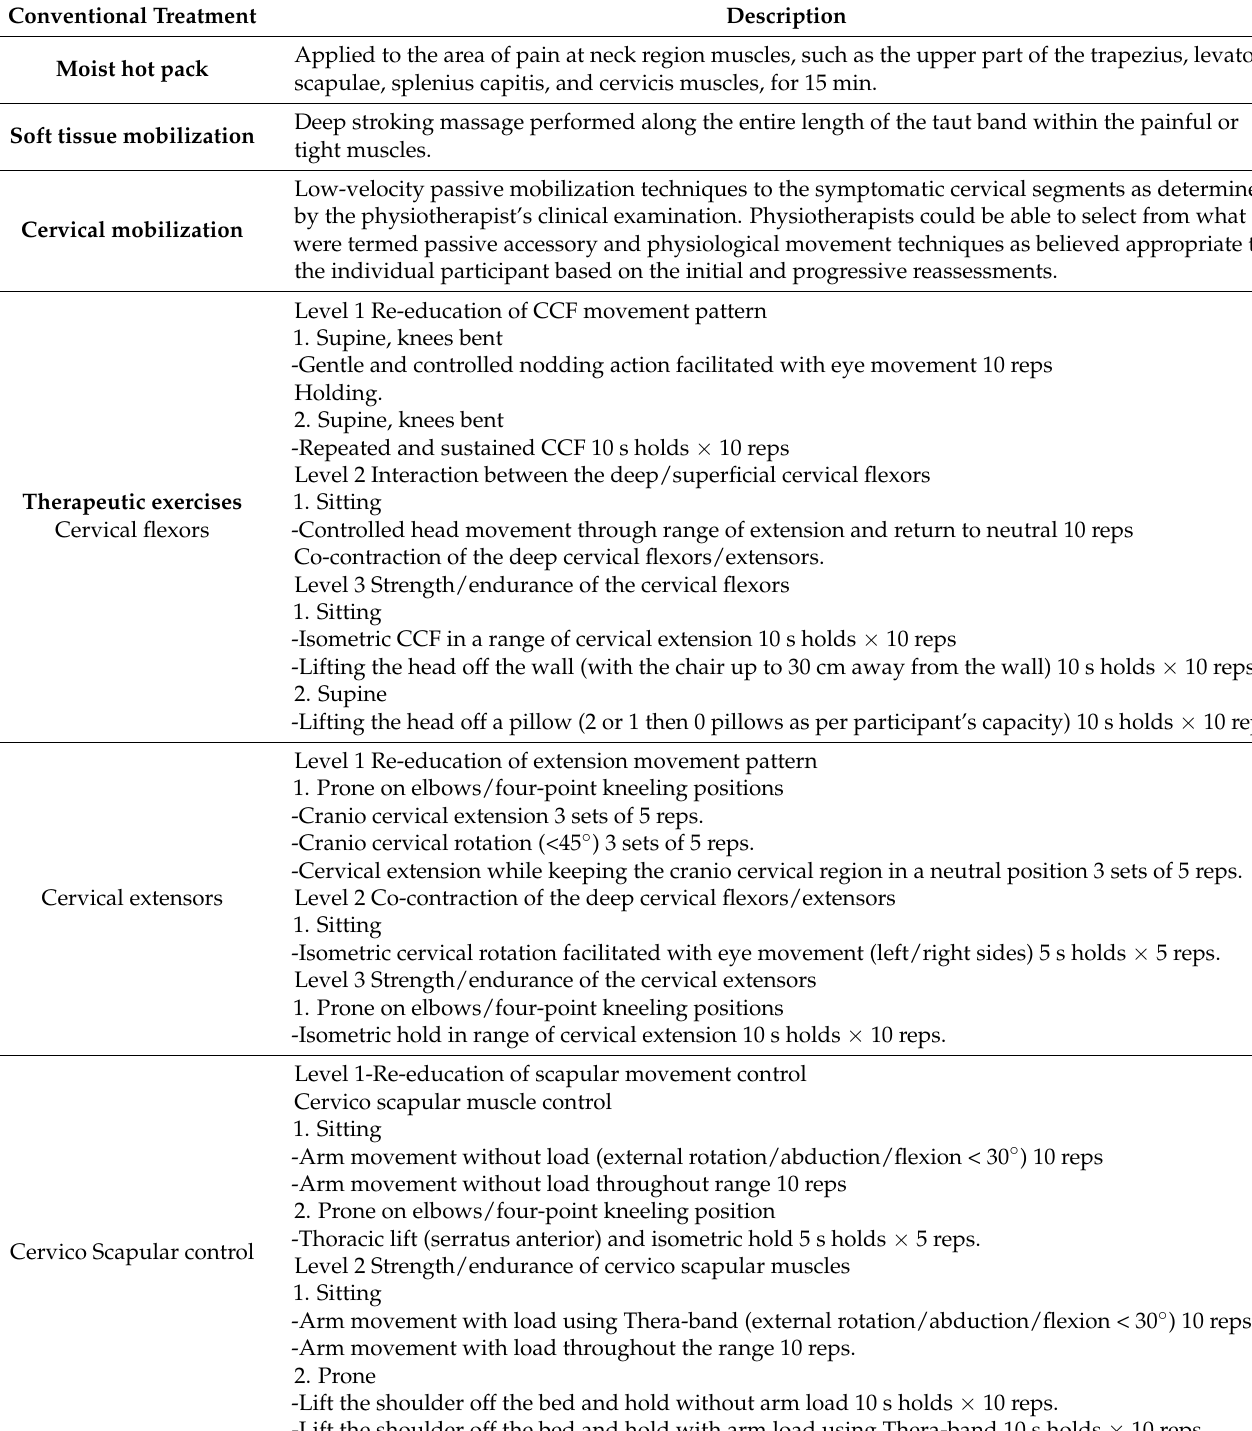
Table 1. Both the study and control groups received conventional or local treatment consisting of a moist hot pack, soft tissue mobilization, manual therapy, and therapeutic exercises. Description of this conventional treatment, exercise prescription, and progression are presented herein. Participants in both groups attended 30 physical therapy treatment sessions over a 10-week period at 3 sessions per week. See methods section for complete details of